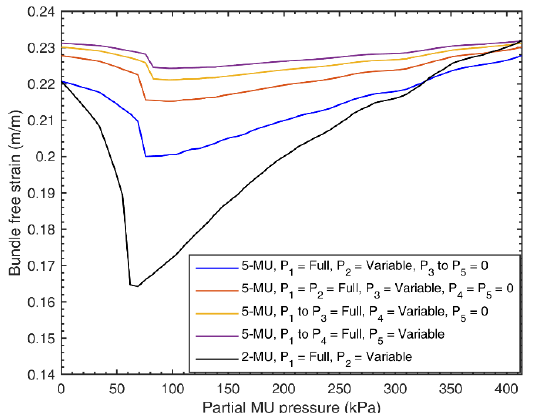
Figure 14. Model comparison of bundle free strain vs. the motor unit (MU) pressure while transitioning between recruitment states 1 and 2 for a bundle consisting of five FAMs. 𝑃 𝑛 denotes the pressure applied to MU 𝑛 . The black line represents a bundle with two MUs, one containing a single fluidic artificial muscle (FAM) and the other containing four FAMs. The colored lines represent the different recruitment states a of a five-FAM bundle that consists of five MUs (i.e., one FAM per MU).